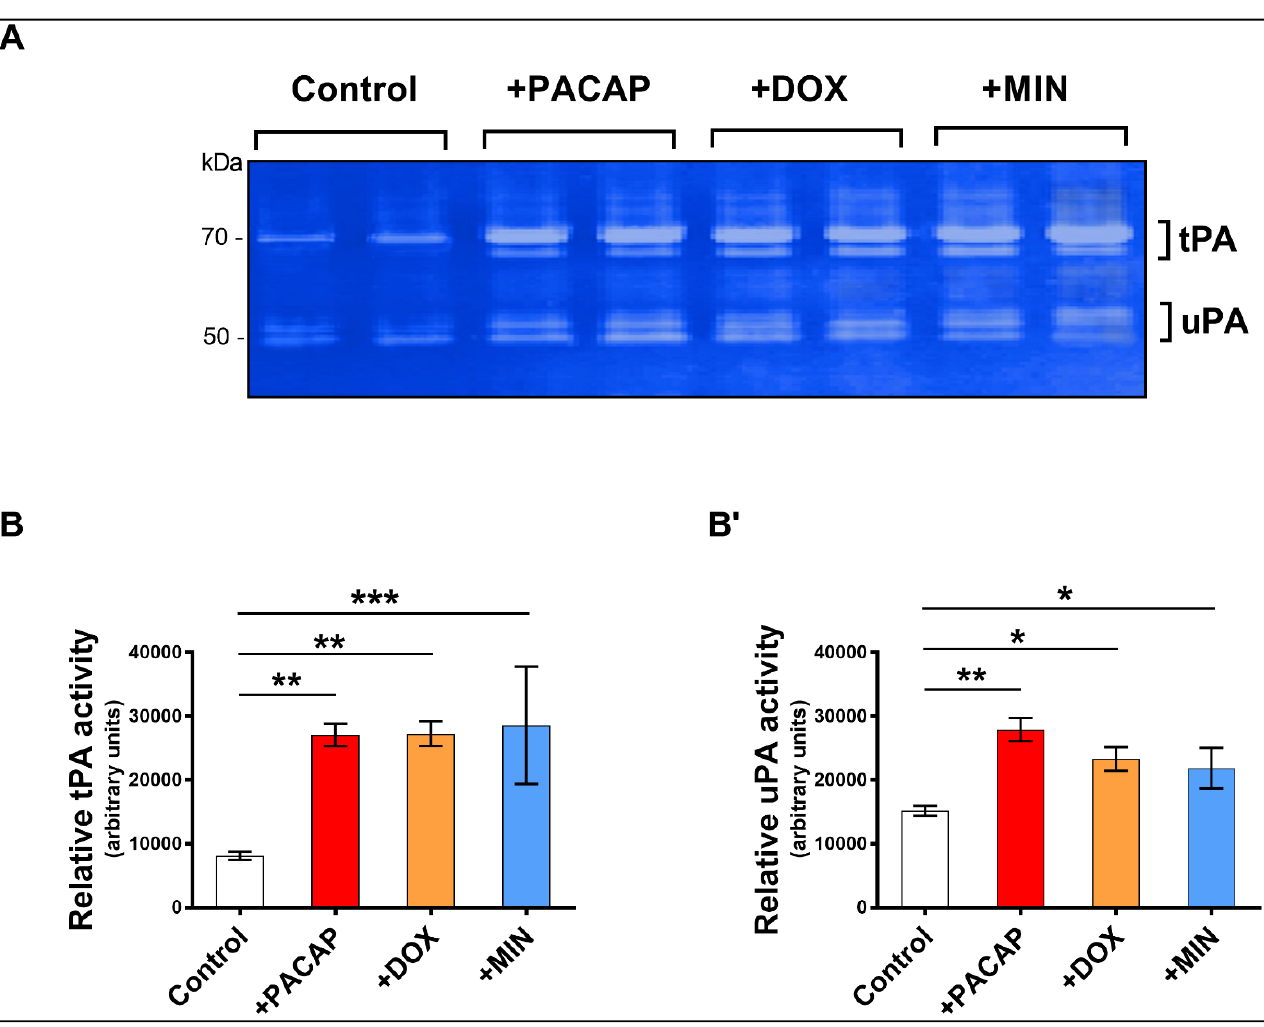
Figure 3. Zymographic assessment of tPA and uPA activity of RT4 cells in response to PACAP, doxycycline or minocycline. ( A ) Representative zymogram and densitometric analyses showing the relative levels of ( B ) tPA and ( B’ ) after treatment with PACAP, doxycycline or minocycline for 24 h. Values reported (arbitrary units) are the mean ± S.E.M. of two separate experiments, each run using distinct batches of cells (n = 4/group), measured using ImageJ software. * p < 0.05, ** p < 0.01 or *** p < 0.001, as determined by ANOVA followed by Dunnett’s post-hoc test.